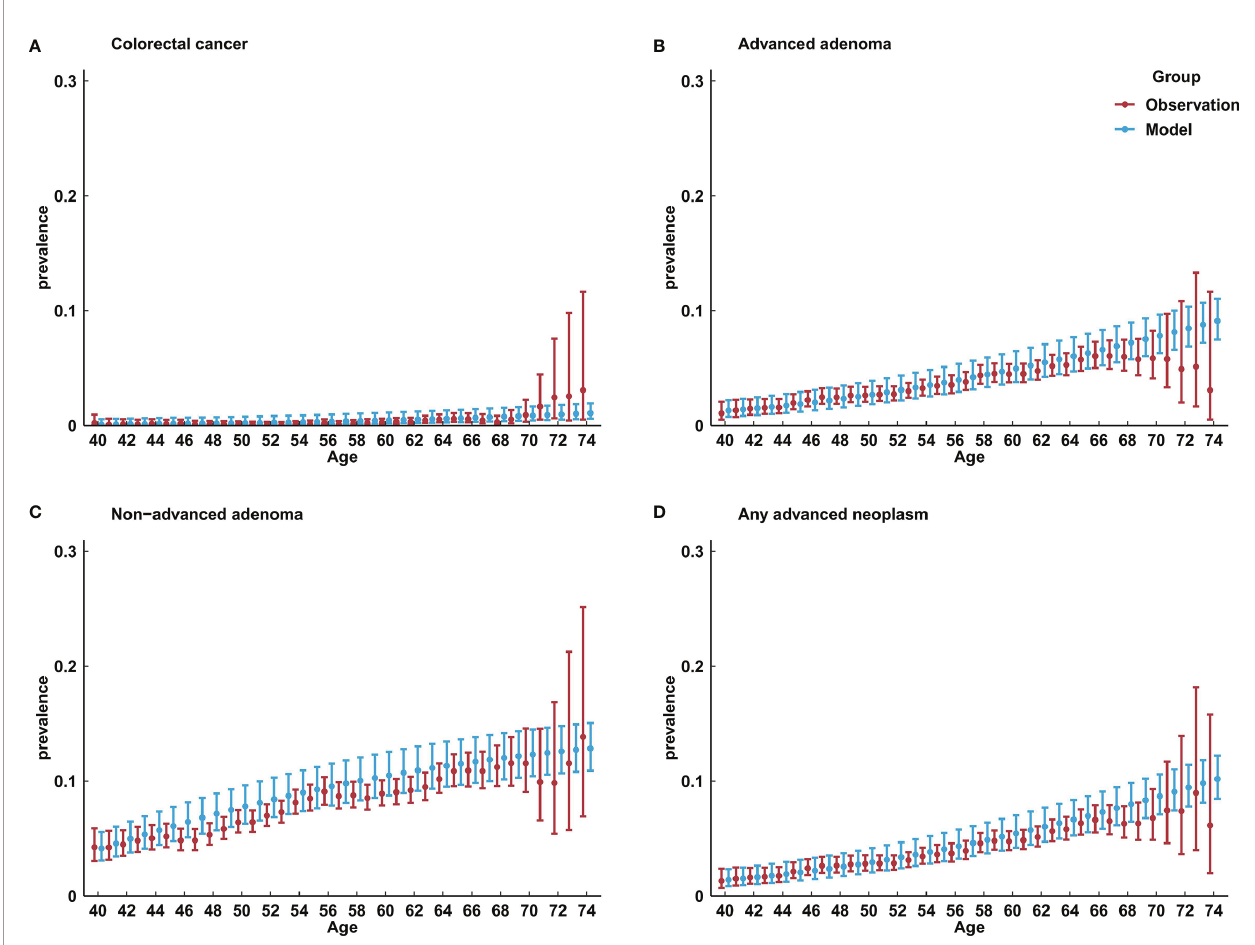
FIGURE 2 | Comparison of model-predicted prevalence of colorectal lesions with the observed results in China. (A) prevalence of colorectal cancer; (B) prevalence of advanced adenoma; (C) prevalence of non-advanced adenoma; (D) any advanced